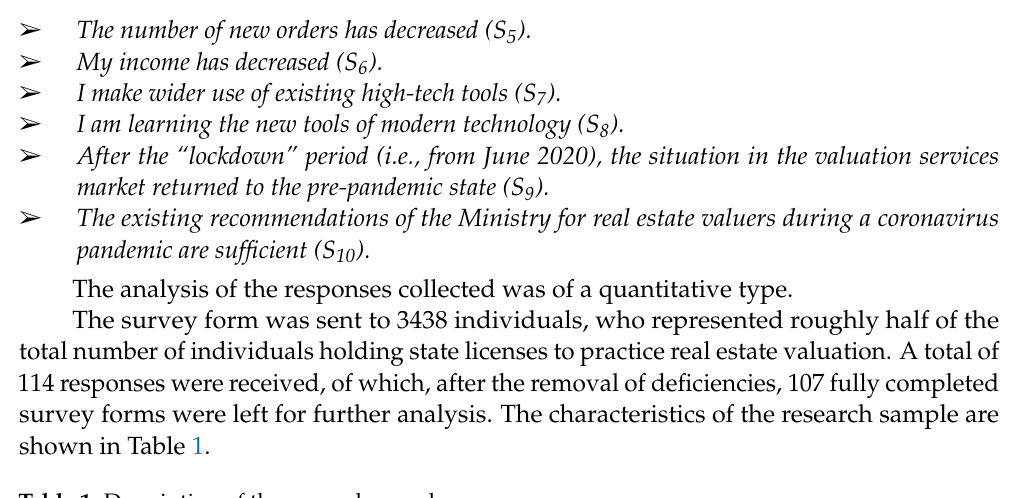
Table 1. Description of the research